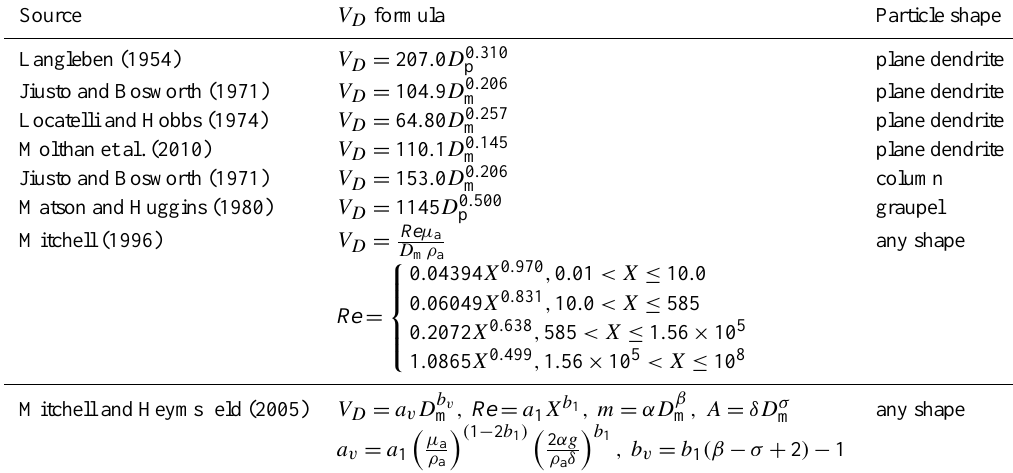
2 m , α , β , δ , and Aµ 2 a Particle